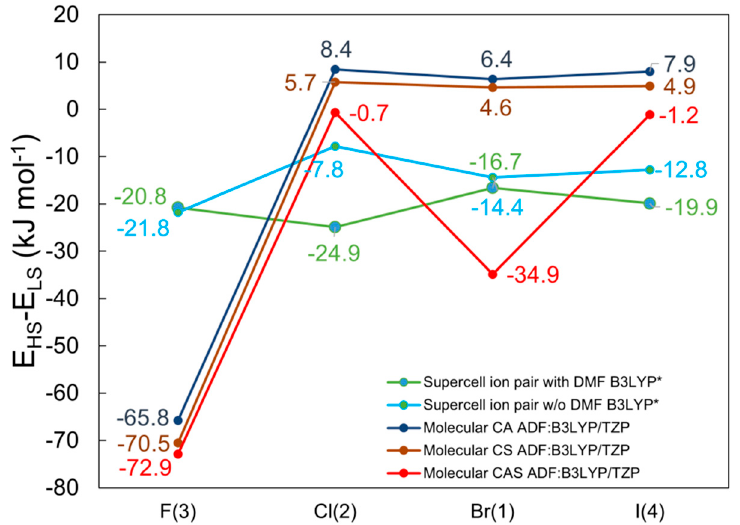
Figure 6. Energy difference between spin states ( ∆ E HS-LS , kJ mol − 1 ) for all the periodic (B3LYP* functional) and molecular DFT calculations of complexes 1 (Br), 2 (Cl), 3 (F), and 4 (I).